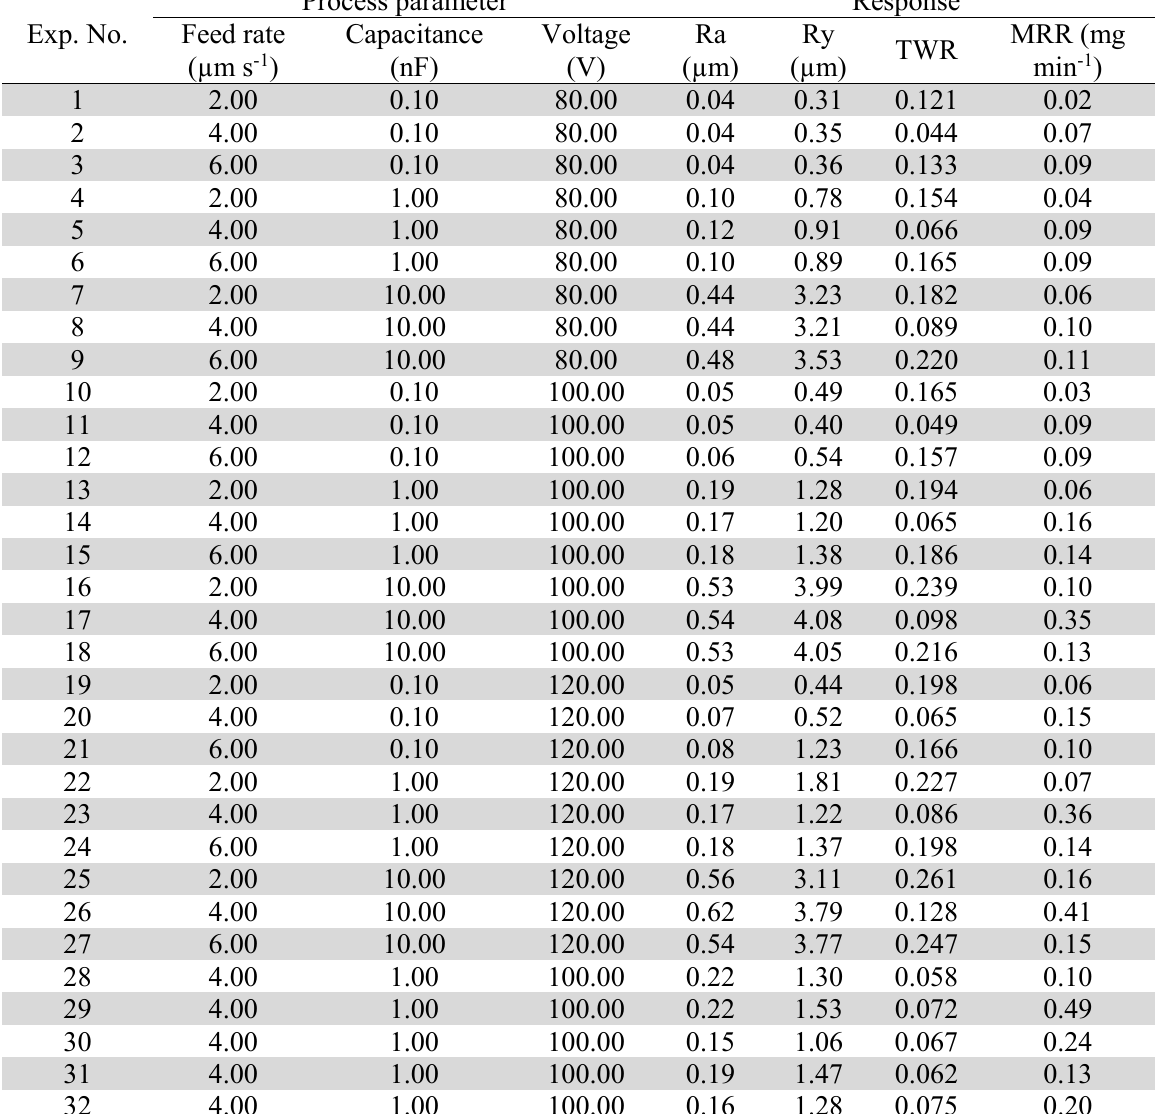
Experimental results of micro electro discharge milling process (Mehfuz & Ali, 2009) Exp.